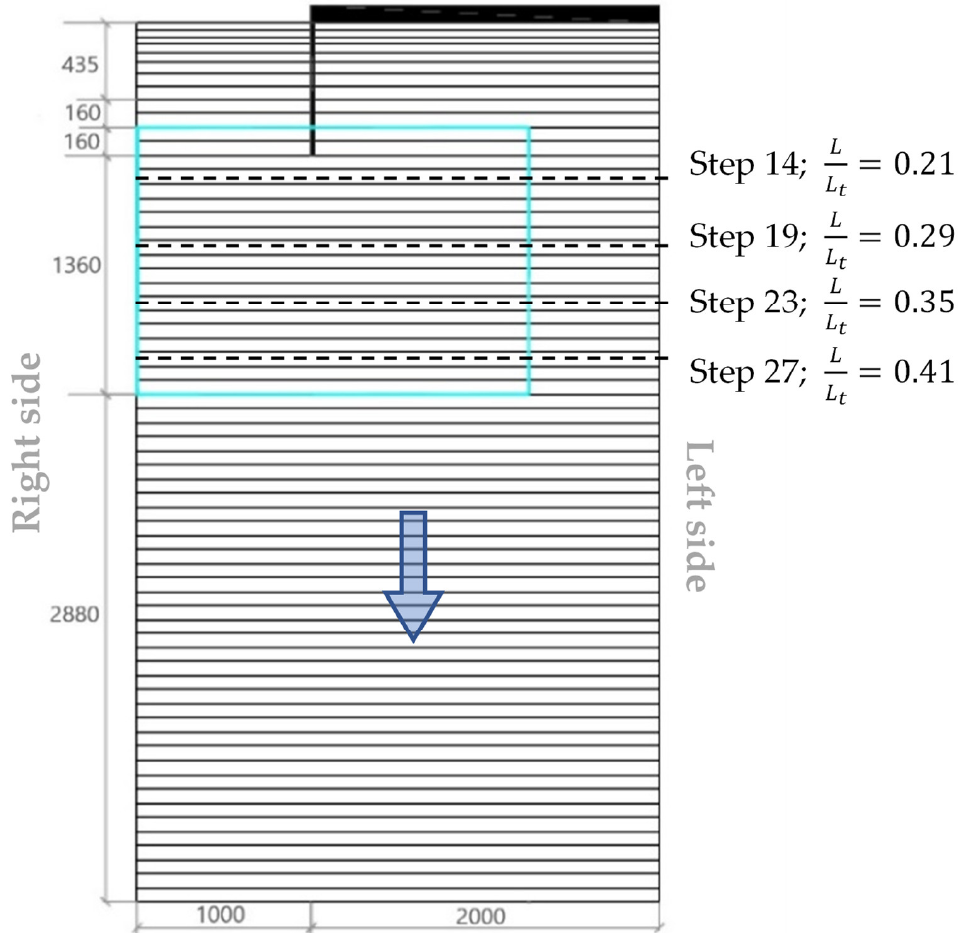
Figure 2. Plain view of the stepped chute (dimensions in mm). The guiding wall at 1 m from the right side is shown. The field of view of the camera covers an area from L / L t = 0.17 to 0.44 (step 11 to step 29), and transversely, up to 2.5 m from the right side of the chute.